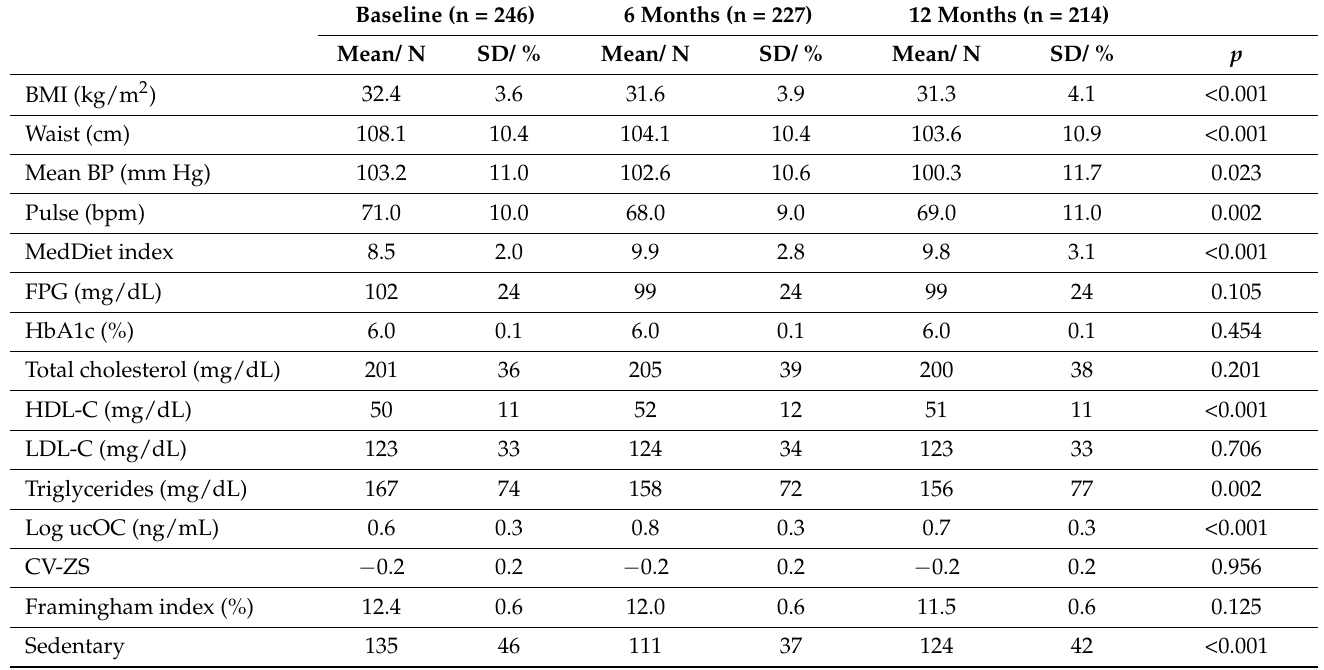
Table 2. Evolution of MetS risk factors, CVS and serum ucOC levels.